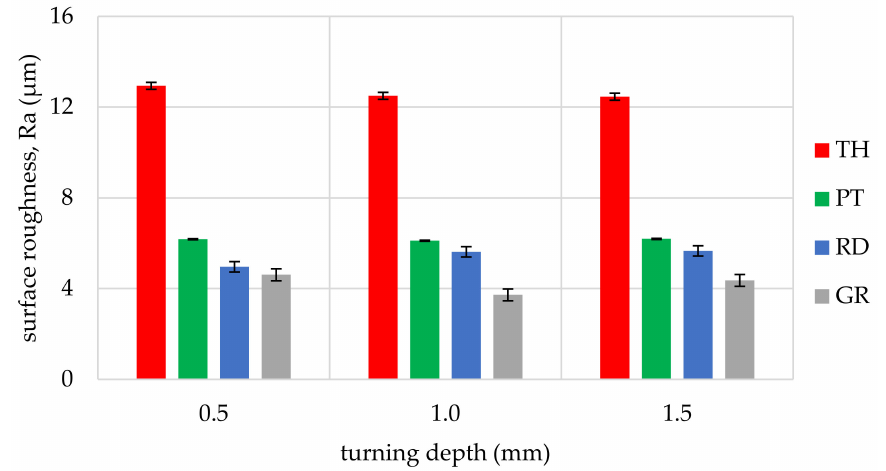
Figure 7. Influence of turning depth and type of cutting insert on surface roughness of San Domingo Boxwood, Phyllostylon brasiliense